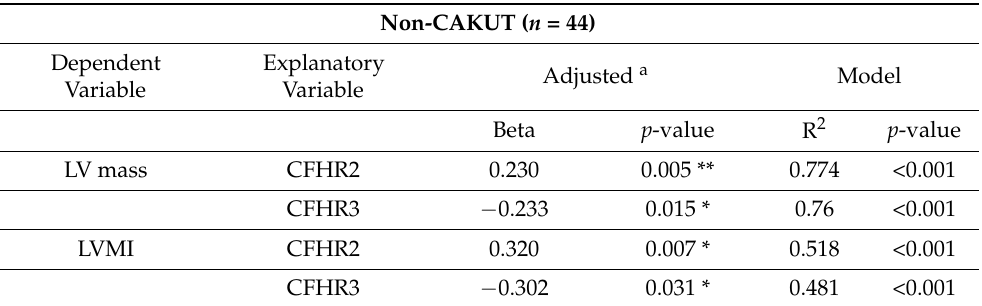
Table 6. Regression model of cardiovascular risks and CFH-related proteins in the non-CAKUT